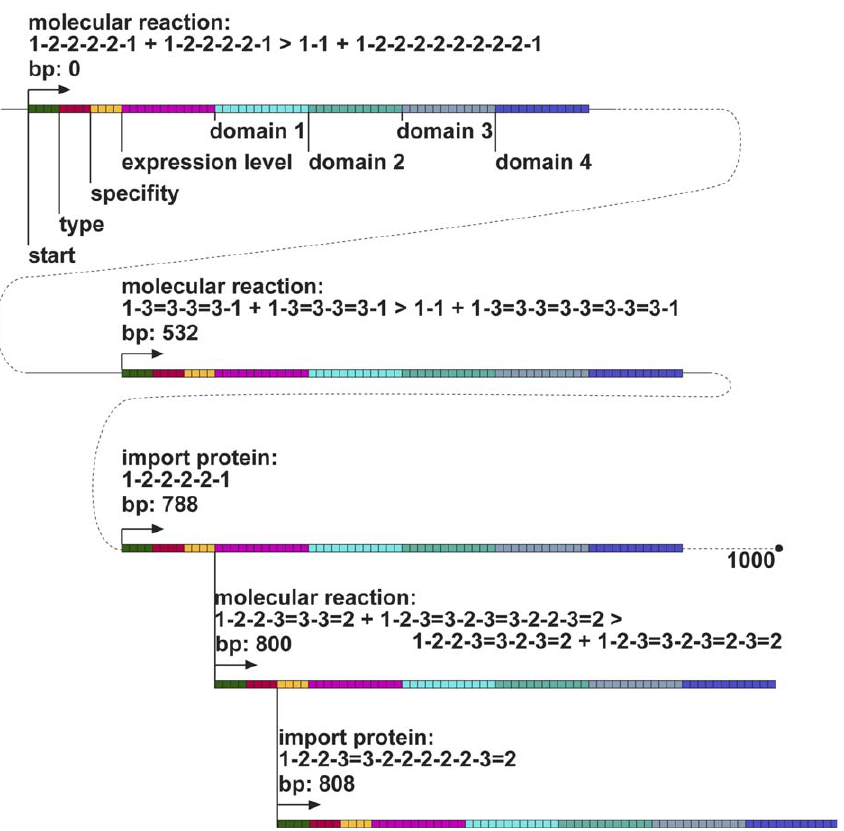
Figure 11. Structure of the 1,000 bp Ancestral Genome Used To Start All Evolutionary Runs Each gene begins with a start codon (green), followed by type, expression level, and specificity determining regions (red, yellow, pink, respectively), followed by domains encoding protein affinity. The last two reading frames (at 800 bp and 808 bp) are overlapping